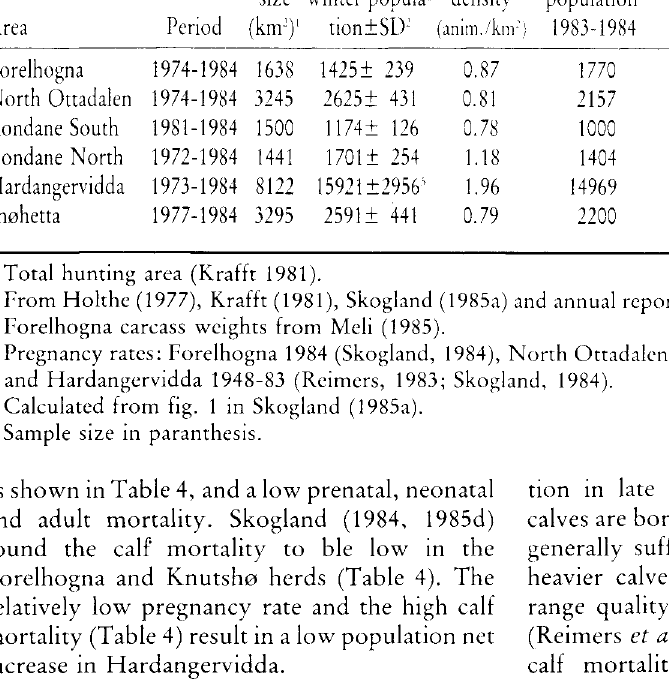
Table 2. Average population size and density (winter), female carcass weights and pregnancy rates. Female carcass Area Average size of Corresp.